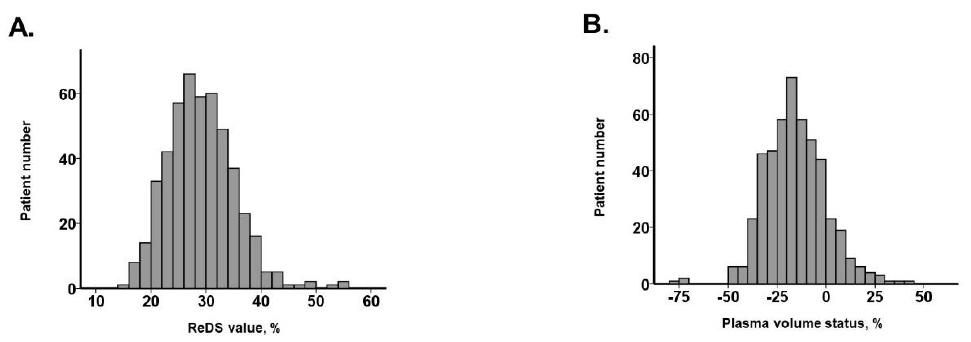
Figure 1. Distribution of ReDS value ( A ) and PVS ( B ).